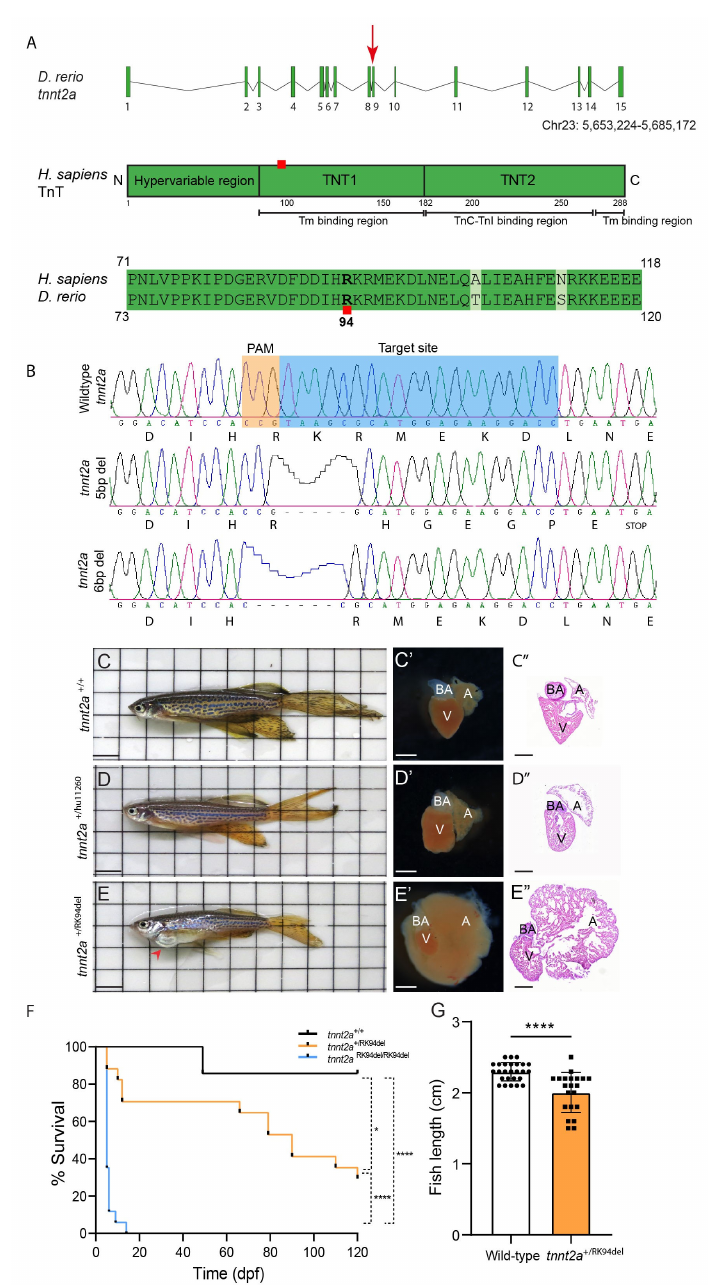
Figure 1. CRISPR/Cas9-induced mutation in tnnt2a promotes the formation of cardiomyopathy in adult zebrafish. ( A ) Illustration of tnnt2a exons, introns, and chromosome location. Red arrowhead indicates the CRISPR/Cas9 mutation location. The cardiac Troponin T (TnT) human protein is schematically depicted, showing the different regions (hypervariable region, TNT1, and TNT2) that interact with tropomyosin I binding region and Troponin C and I (TnC-TnI) binding region, spanning 288 amino acids. The Arginine mutation site is highlighted with a red square, located on position 94 in zebrafish ( D. rerio ), which corresponds to the Arginine amino acid 92 in humans ( H. sapiens ). ( B ) Two different mutations targeting exon 9 of tnnt2a were identified, either causing a 5 bp frameshift deletion and a truncated form of the protein or a 6 bp in-frame deletion causing a mutated form of the protein. The target sequence for CRISPR/Cas9 is shown in blue and the PAM sequence in orange. The amino acid sequences show the effect of the mutations on the protein. ( C – E ) Images of